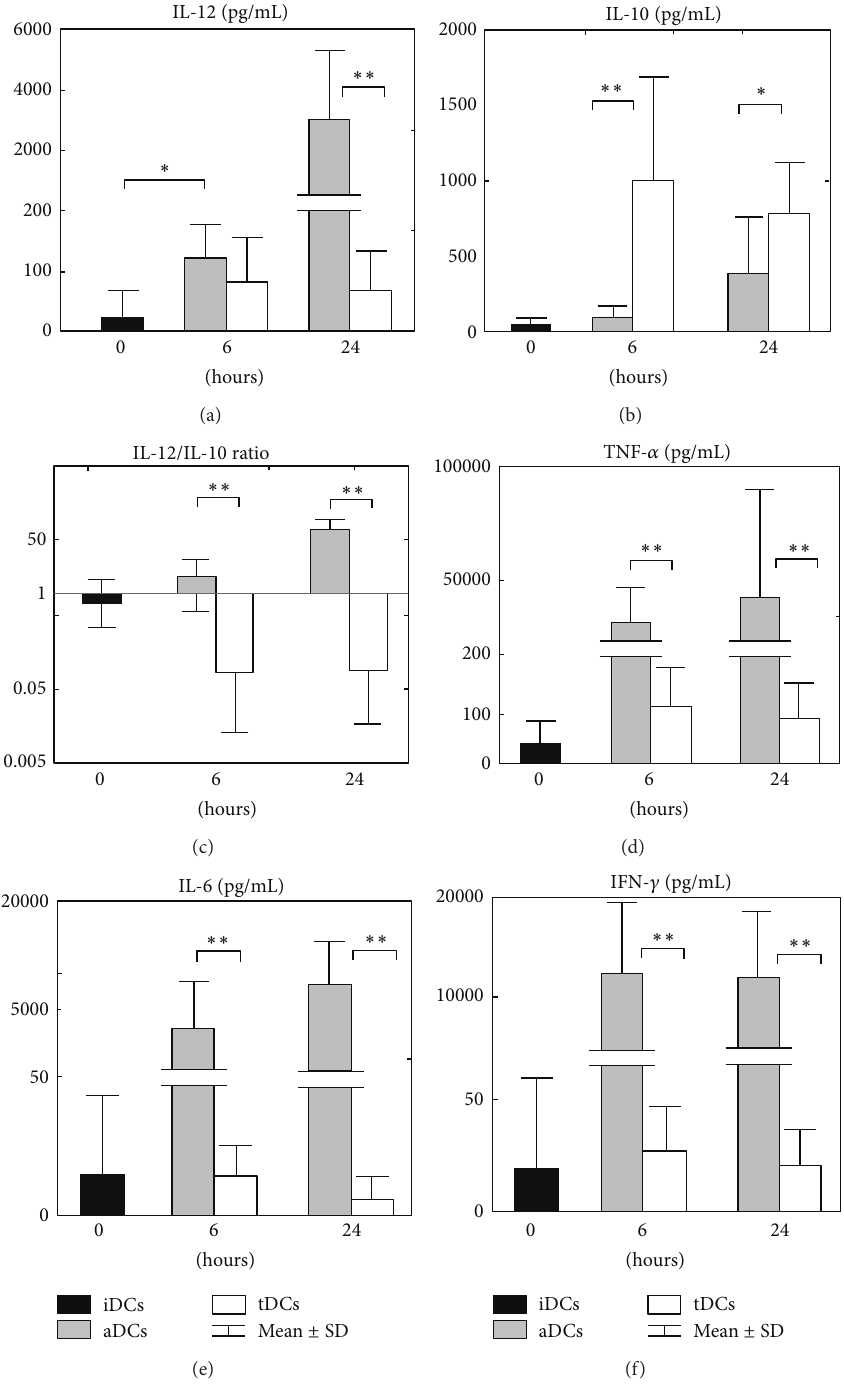
Figure 2: Quantification of cytokines in DCs upon maturation. Immature iDCs were cultured with GM-CSF (800UI/mL) and IL-4 (500 UI/mL) for 6 days. On day 6, iDCs media were replaced with media containing LPS and IFN- 𝛾 (activated DCs: aDCs) or with media containingIL-10andTGF- 𝛽 (tolerogenicDCs:tDCs)fornext6hor24hmaturation.Thecytokinesconcentrationsweremeasuredincollected DCs culture media by bead based FACSArray. (a) Concentration of IL-12p70 (pg/mL). (b) Concentration of IL-10 (pg/mL). (c) Ratio of IL-12- p70/IL-10 calculated from absolute values measured for both cytokines in pg/mL and related to the particular experiment. (d) Concentration of TNF- 𝛼 cytokine (pg/mL). (e) Concentration of IL-6 cytokine (pg/mL). (f) Concentration of IFN- 𝛾 (pg/mL). The 𝑦 -axis represents the concentrations of cytokines in pg/mL. The results are expressed as mean ± SD of eight individual experiments. ∗ 𝑃 < 0.05 ; ∗∗ 𝑃 < 0.001 (significant difference to iDCs). Exact 𝑃 values are given in Section